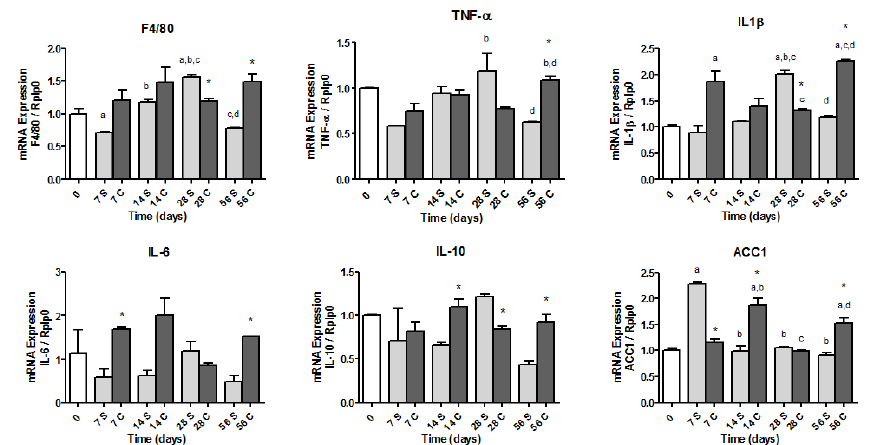
Figure 2. mRNA expression of inflammatory genes and acetyl-CoA carboxylase 1 (ACC1) in the livers of mice fed with a diet containing soybean oil (S group) or canola oil (C group) as a lipid source, at 0, 7, 14, 28, or 56 days after starting the diets. Abbreviations: TNF- α, tumor necrosis; IL, interleukin. Results are expressed as mean ± standard error. p < 0.05 as compared with day 0 a , day 7 b , day 14 c , day 28 d , and S group *.